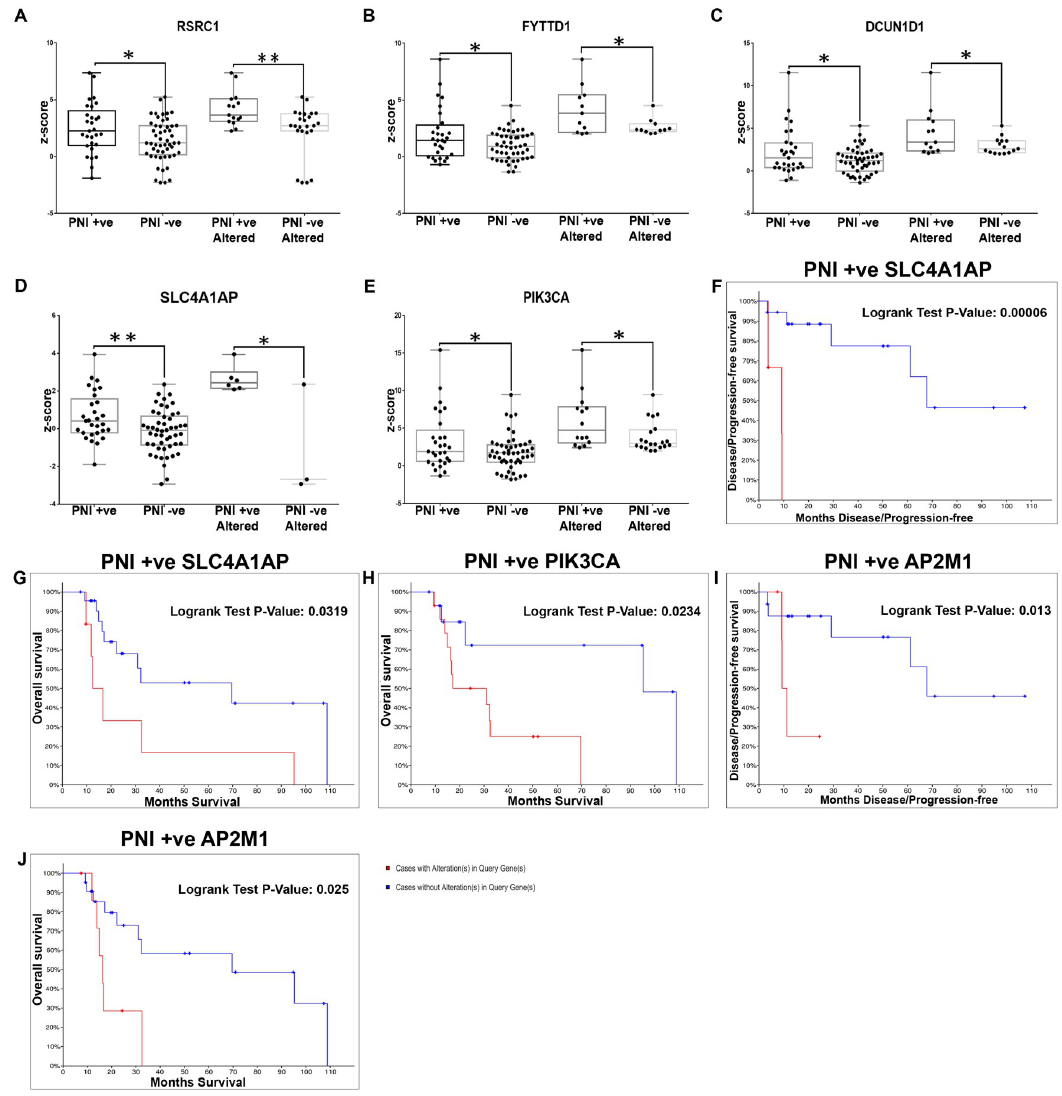
Fig 5. Molecular markers with significant differential expression and prognostic efficacy in laryngopharyngeal cancers with perineural invasion. Validation of the differentials identified in the laryngopharyngeal cancer within the TCGA cohort of patients with perineural invasion identified 7 gene panel based on differences in mRNA expression levels (z-score), the top 5 based on percentage alteration being RSRC1, FYTTD1, DCUN1D1, SLC4A1AP and PIK3CA was upregulated in altered cases of PNI positive patients (A-E) . From among this cohort, SLC4A1AP showed an association in both DFS ( F ; p = 0.00006569) and OS ( G ; p = 0.0319), whereas PIK3CA was associated with overall survival ( H ; p = 0.0234). Assessment of the prognostic efficacy of the genes with alterations > 20% identified AP2M1 as the sole marker with survival impact on both OS ( I ; p = 0.013) and DFS ( J ; p = 0.025). (P- value; � p < 0.05; �� p < 0.005).